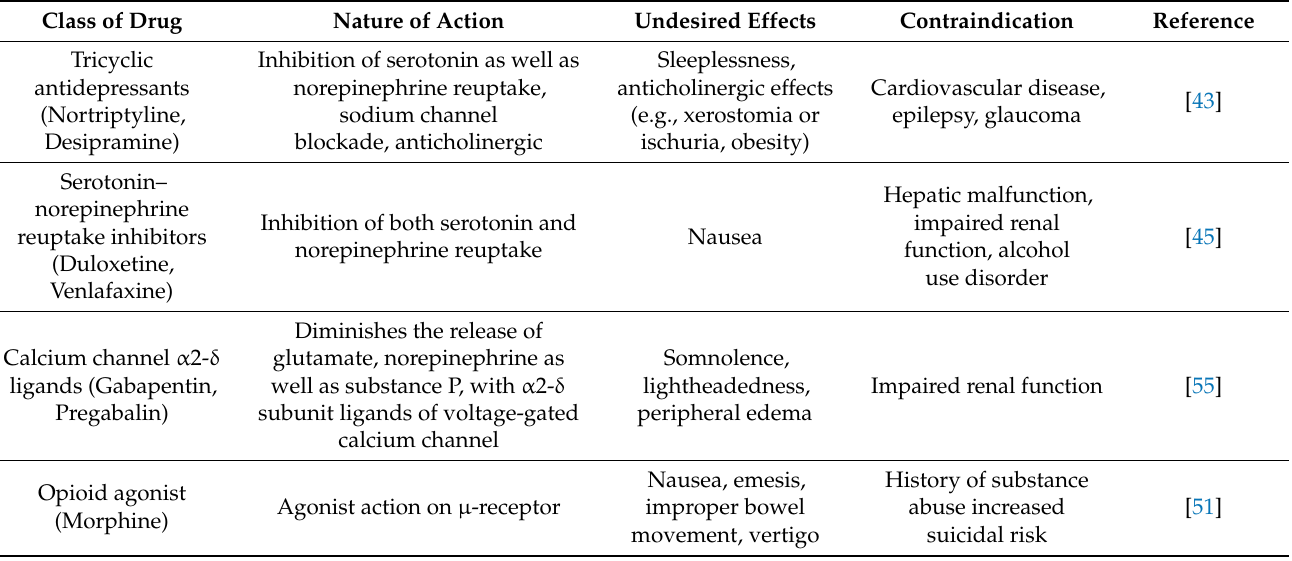
Table 1. Current pharmacotherapies used in neuropathic pain